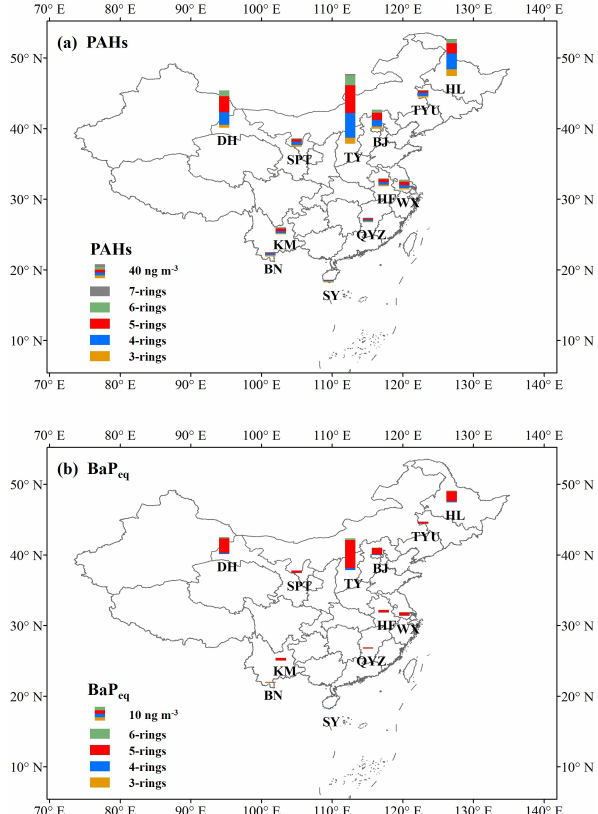
Figure 1. Annual averages of (cid:80) 24 PAHs (a) and BaP eq (b) at 12 sites in